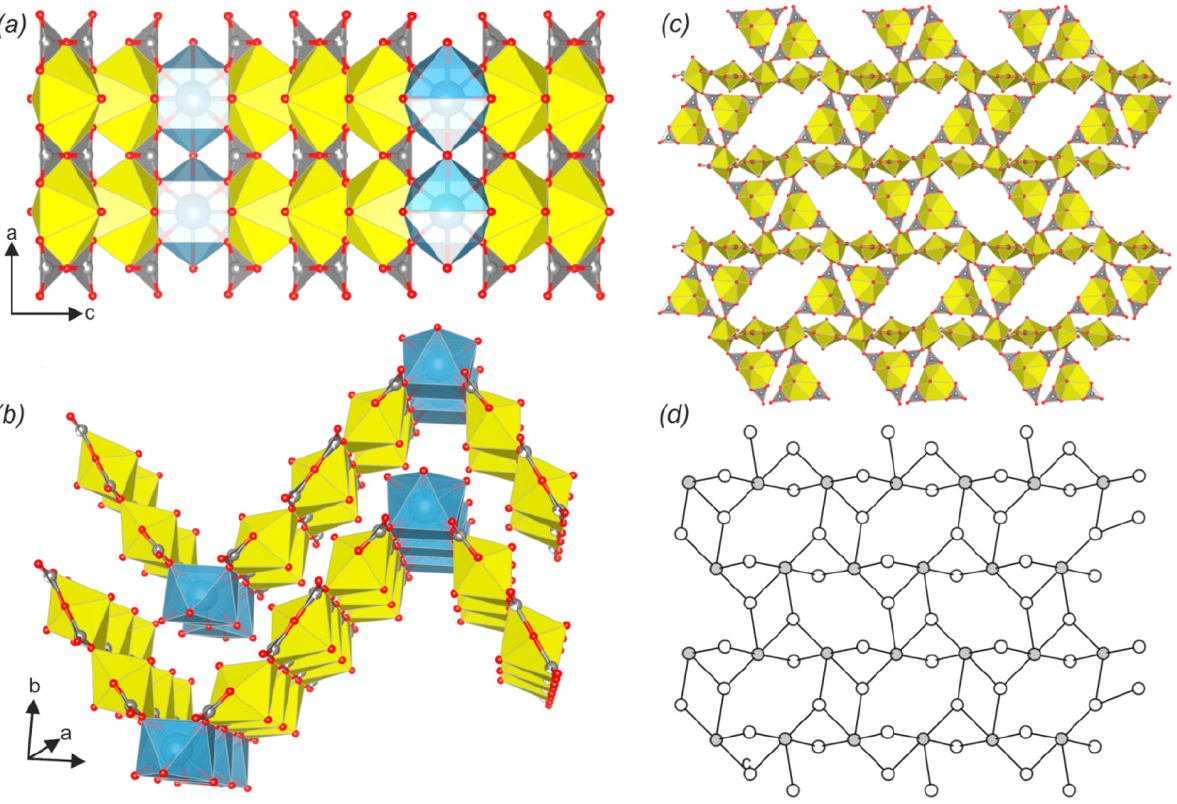
Figure 4. The crystal structures of sharpite ( a , b ) and meyrowitzite ( c ) with simplified topological representation ( d ). Legend: see Figure 1; Ca polyhedra = light blue.